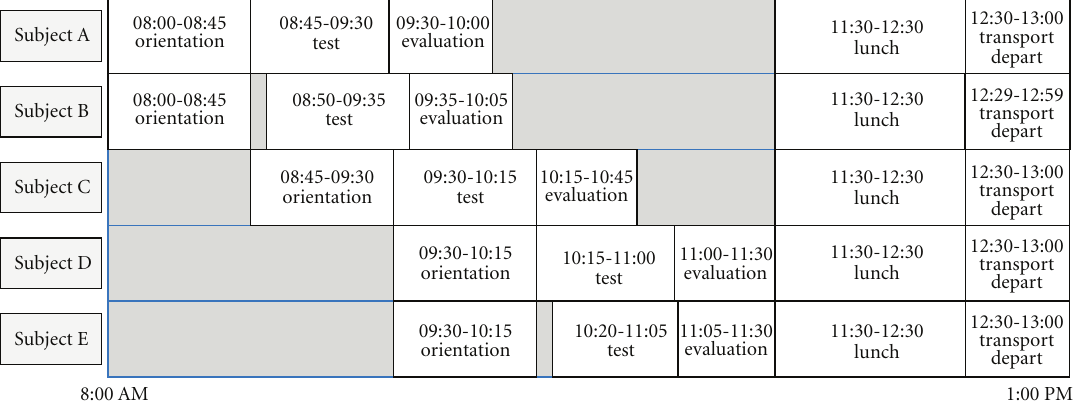
Figure 7: Phase I trials schedule.